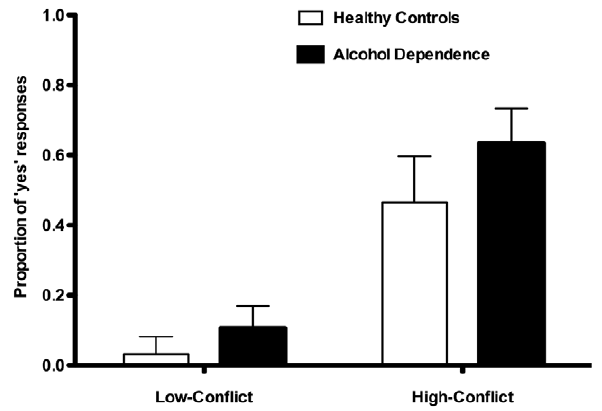
Figure 2. Moral judgments of the personal moral dilemmas, further subdivided into low- and high-conflict respectively. The proportion of ‘yes’ responses are shown for the two groups. Alcohol dependent patients were more likely than healthy controls to respond ‘yes’, i.e. endorsing the proposed utilitarian action, when faced with the high-conflict dilemmas (P=0.036), while the difference was less pronounced for the low-conflict dilemmas (P=0.063). Error bars indicate 95% confidence